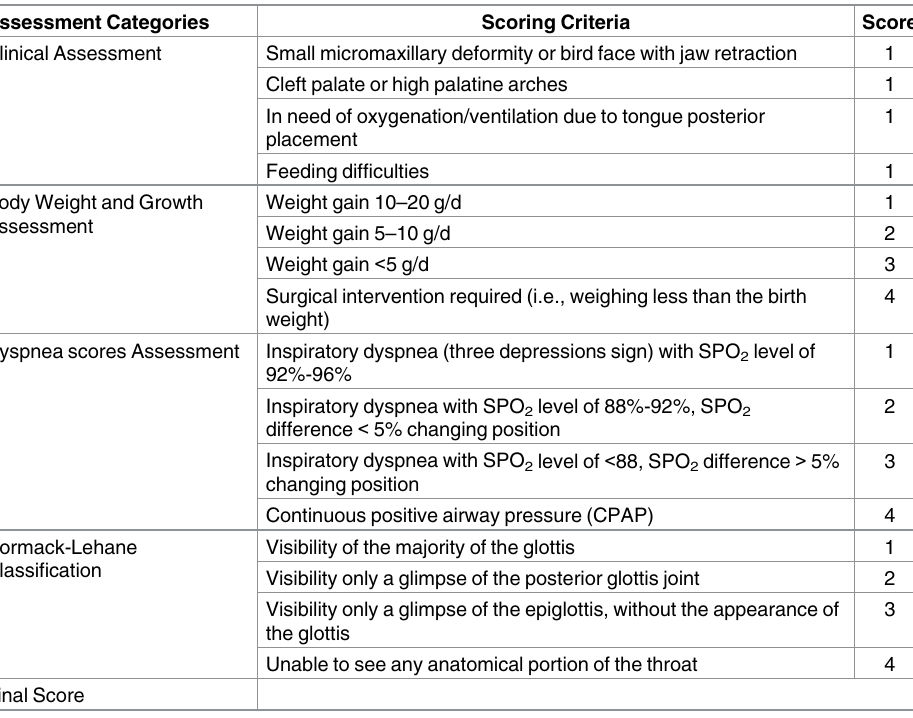
Table 2. Comprehensive scoring